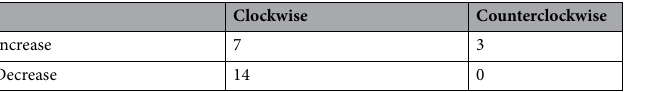
Clockwise Counterclockwise